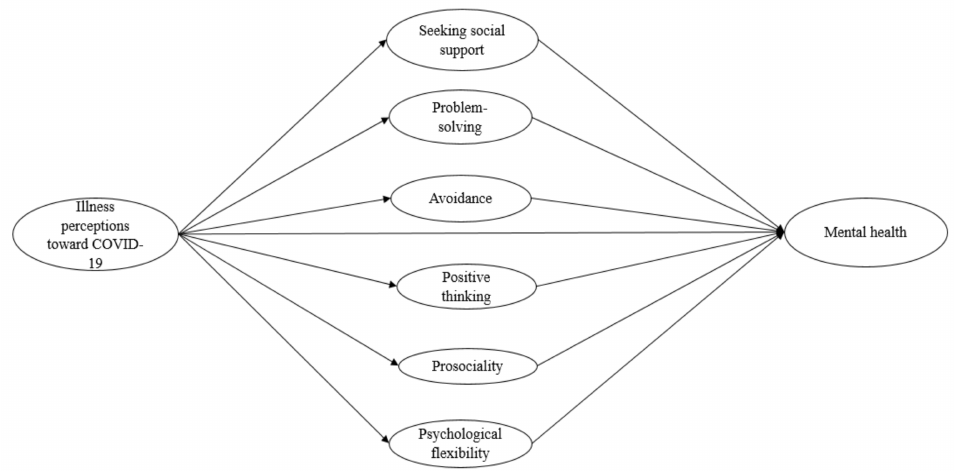
Figure 1. Hypothetical model of the